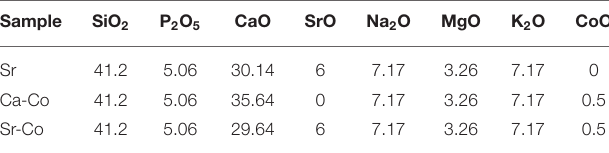
TABLE 1 | The composition of the BGs (mol %) used for stimulating iPSCs osteogenesis (Kargozar et al., 2016).